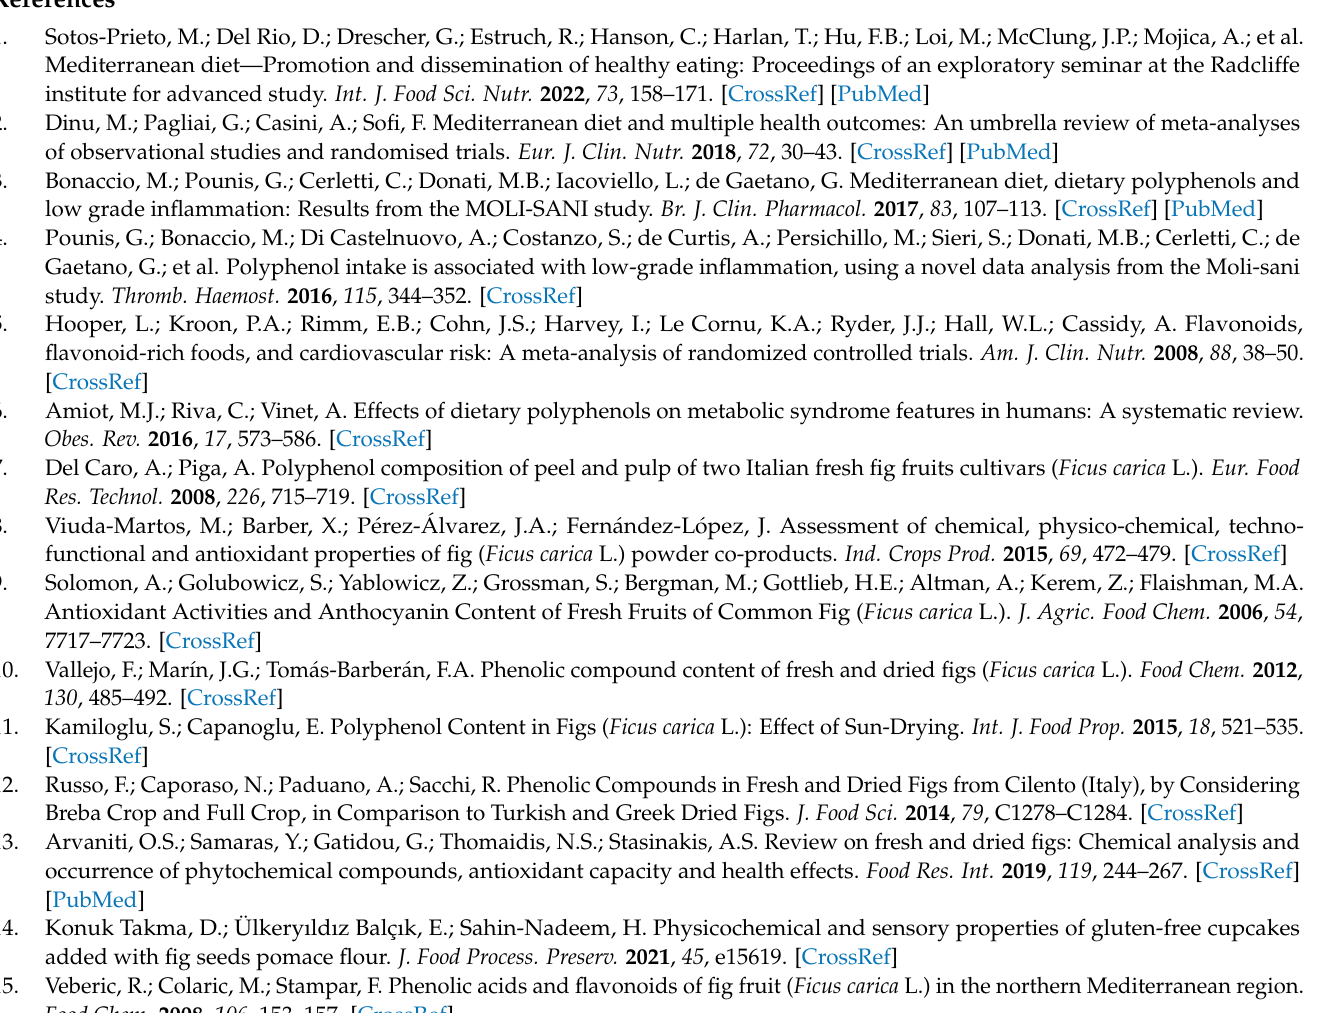
(poly)phenols identified in fig peel and whole dried fig; Figure S1: Chromatographic profiles of caffeoylquinic acids and their MS/MS spectra; Figure S2: Chromatographic profile of quercetin-3- O - rutinoside and its MS/MS spectra; Figure S3: Chromatographic profiles of cyanidin-3- O -glucoside and cyanidin-3- O -rutinoside with their MS/MS